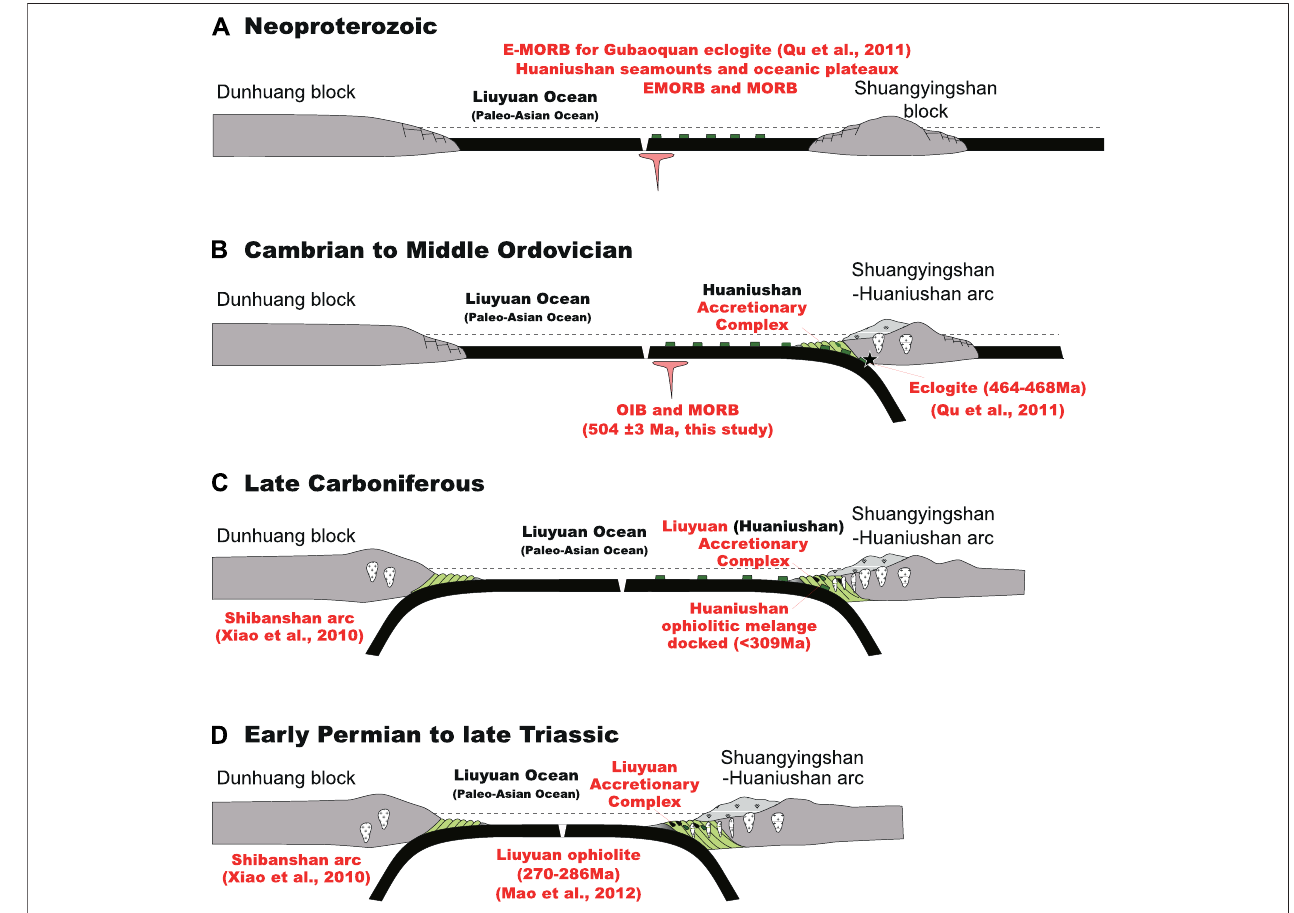
FIGURE 13 | Schematic tectonic diagrams illustrating the development of the Liuyuan accretionary complex in the Beishan orogen, NW China. (A) Neoproterozic. (B) Cambrian to Middle ordovician. (C) Late carboniferous. (D) Early permian to late triassic.